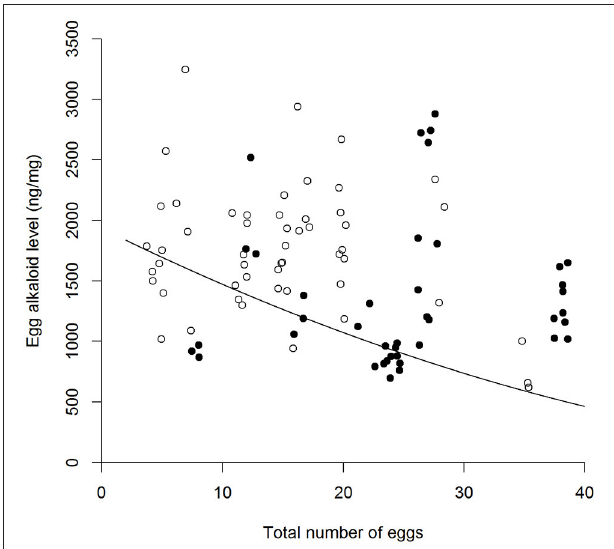
FIGURE 4 | Relationship between the total number of eggs laid by A. bipunctata females and the concentration of the alkaloid (-)-adaline in those eggs (ng/mg), in the absence of aphids (A − ) under different predation risk conditions [ ◦ = no predation risk (P − ), • = predation risk (P + )]. Plotted line represents GLM